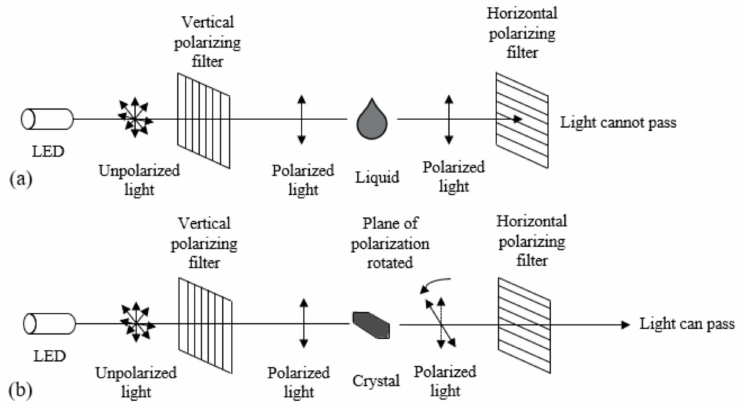
Figure 3. Schematic diagram of microscopic observation method principle. ( a ) homogeneous liquid and ( b ) crystalline material